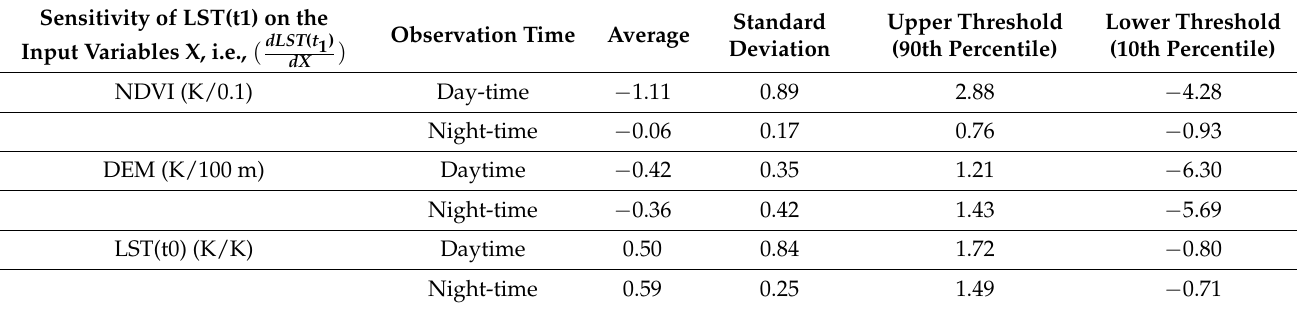
Table 2. Statistical results for sensitivity analysis of the STDF method during the selected study period. The upper and lower threshold of the indicator are respectively defined as the 90th and 10th percentile of all result samples rather than the maximum and minimum values, in order to avoid